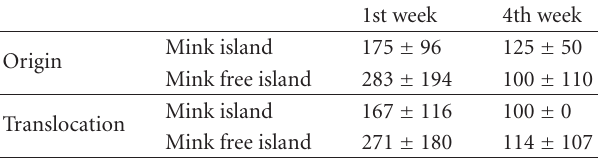
Table 3: Mean and SD of home range sizes (in m 2 ) of voles during first week and fourth week after translocation depending on the island from which a vole originated (origin) and the island where a vole was released (translocation).